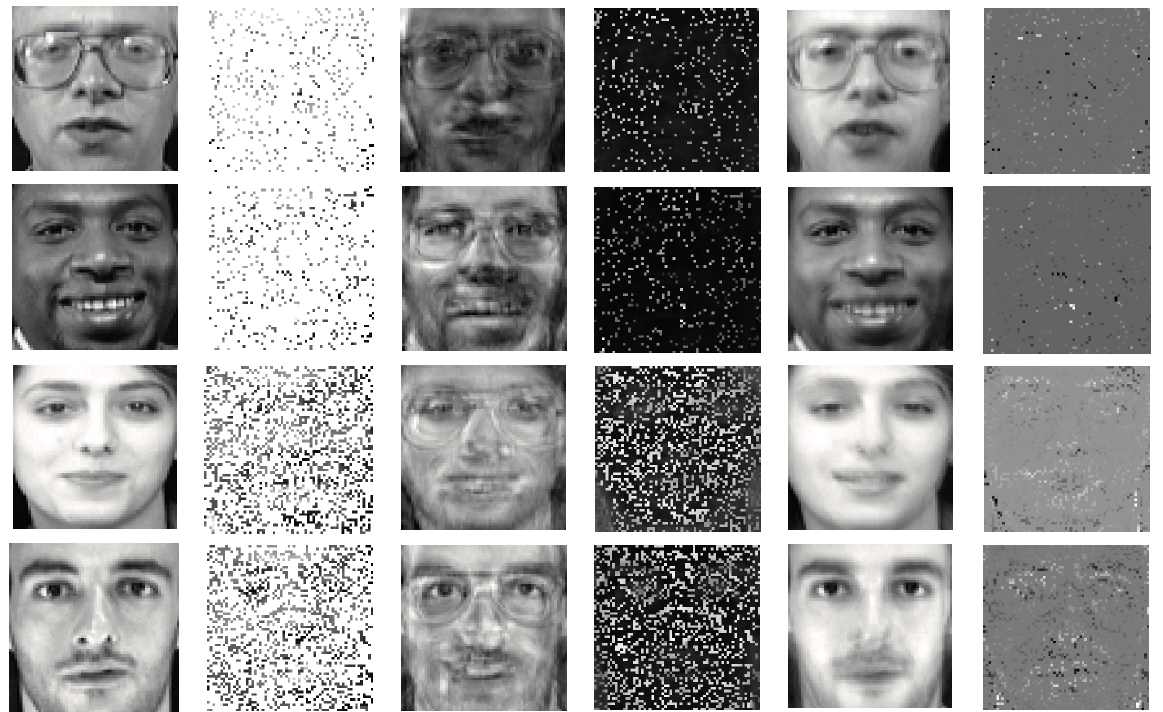
Figure 3. Completion and recovery performance comparisons on ORL.